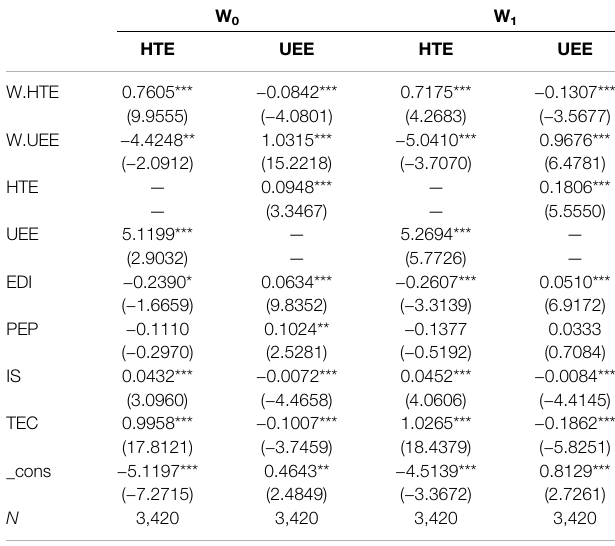
TABLE 7 | Robustness